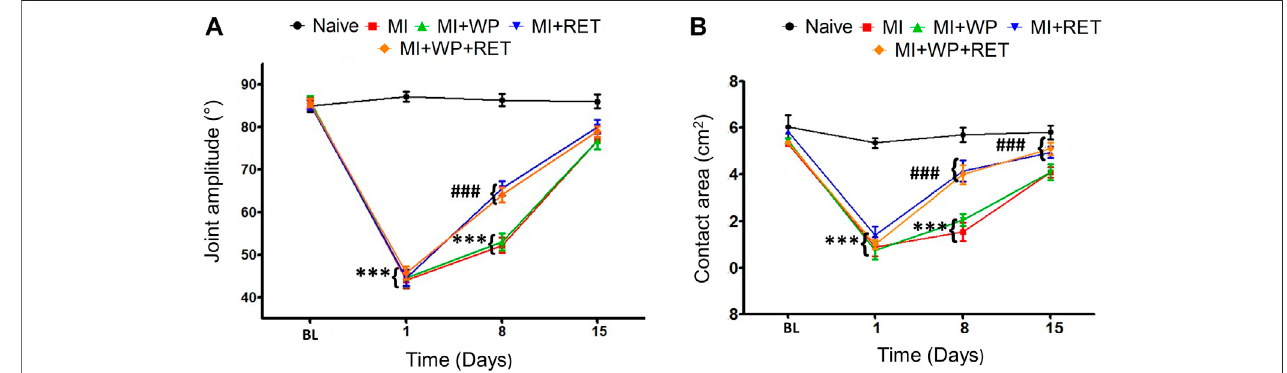
FIGURE 4 | Effect of the resistance exercise training (RET) and whey protein (WP) supplementation on the gait during muscle injury. First, the baseline (BL) of joint amplitude (A) andcontactarea (B) ofthegaitofeachanimalwereevaluated,andanewevaluationwasperformedonthe8thand15thdaysofmuscleinjury(MI).Dataare expressed as the mean ± S.E.M. of six animals per group. *** p < 0.001 indicates statistical signi fi cance compared to the naïve group; *** p < 0.001 indicates statistical signi fi cance compared to the MI group. Two-way ANOVA was followed by the Bonferroni post hoc